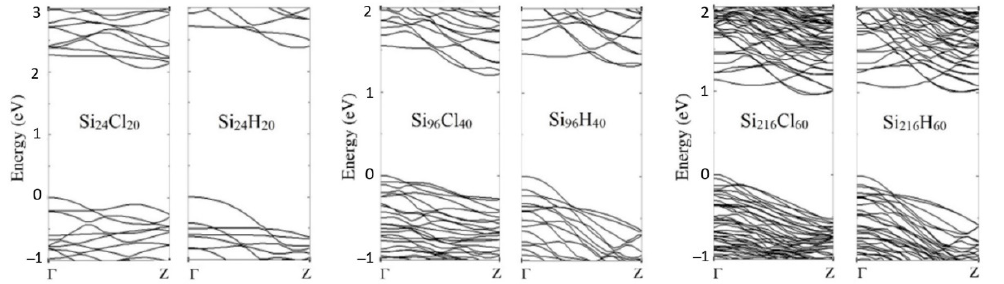
Figure 2. Band structures of fully passivated Cl- and H-functionalized <112> oriented SiNWs. The top of the valence band is set to zero.